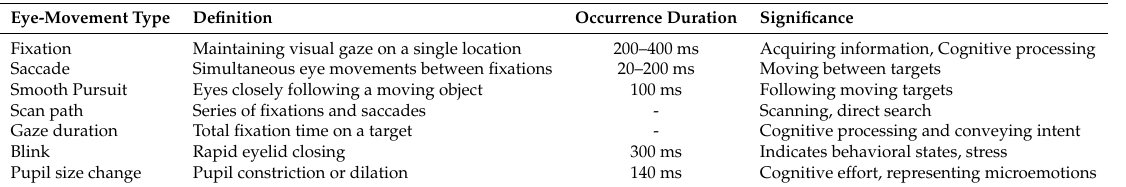
Table 1. Eye-movement classification.